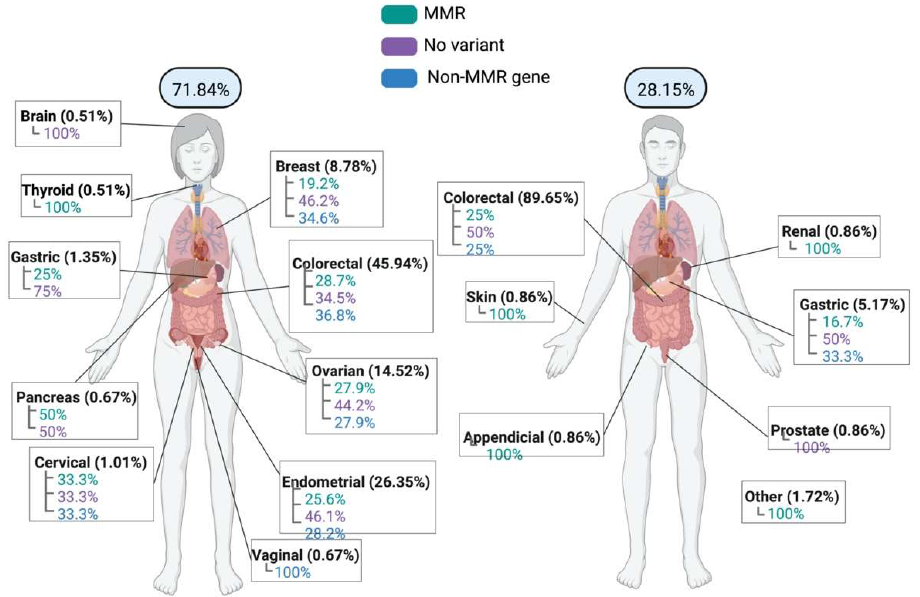
Figure 1. Incidence site in cases of suspected Lynch syndrome by sex. The figure shows the percent- ages of women and men with suspected Lynch syndrome in the cohort, as well as sites of the first tumor diagnosis reported in both women and men. The percentage of reported cases relative to the total number of women and men is shown in parentheses. In each incidence site box, the percentage of cases with variants in MMR (turquoise), no variant identified (purple), and variants in non-MMR genes (blue) are shown.